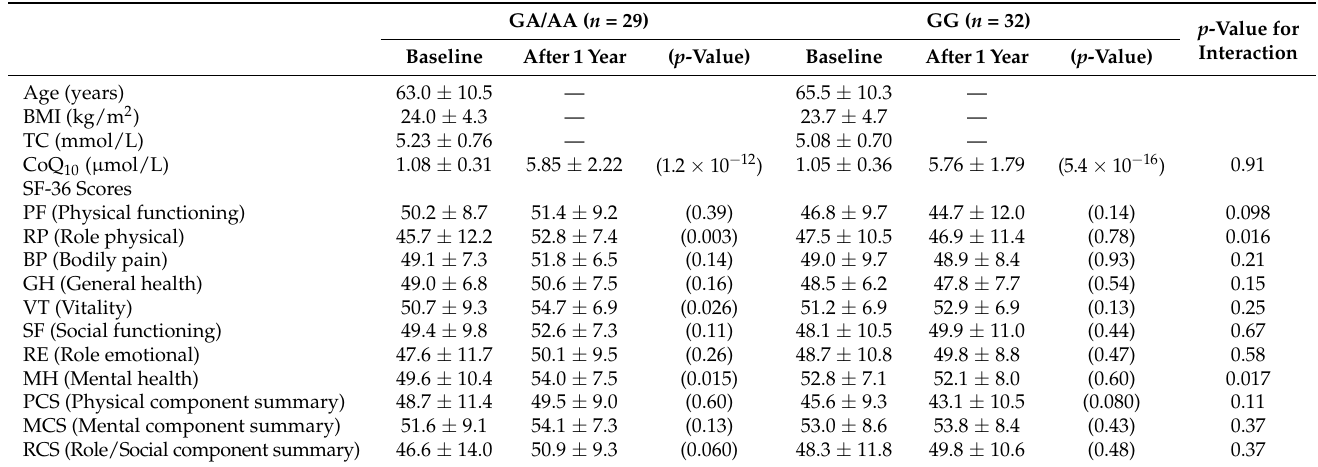
Table 5. Changes in the measurements of rs1761667 (G > A) in CD36 during the reduced CoQ 10 supplementation in women.